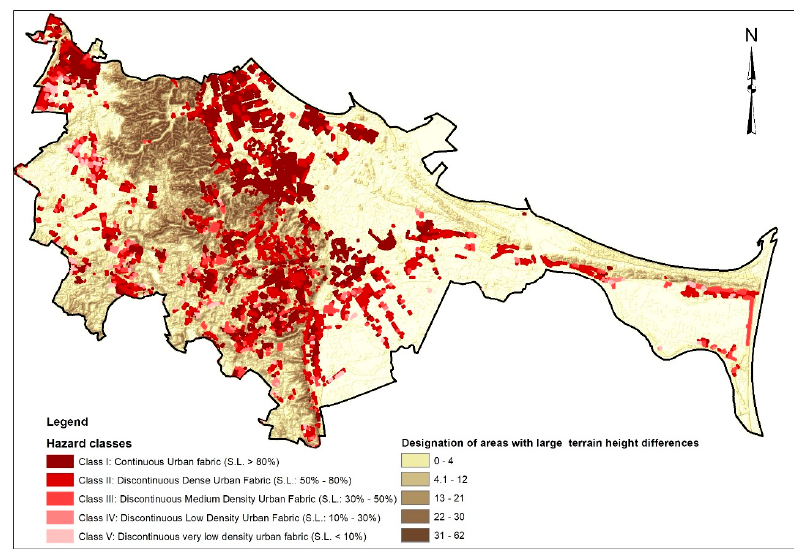
Figure 11. Classification of areas at risk of rainfall flooding (classes from I to V) against the background of areas with large terrain height differences.